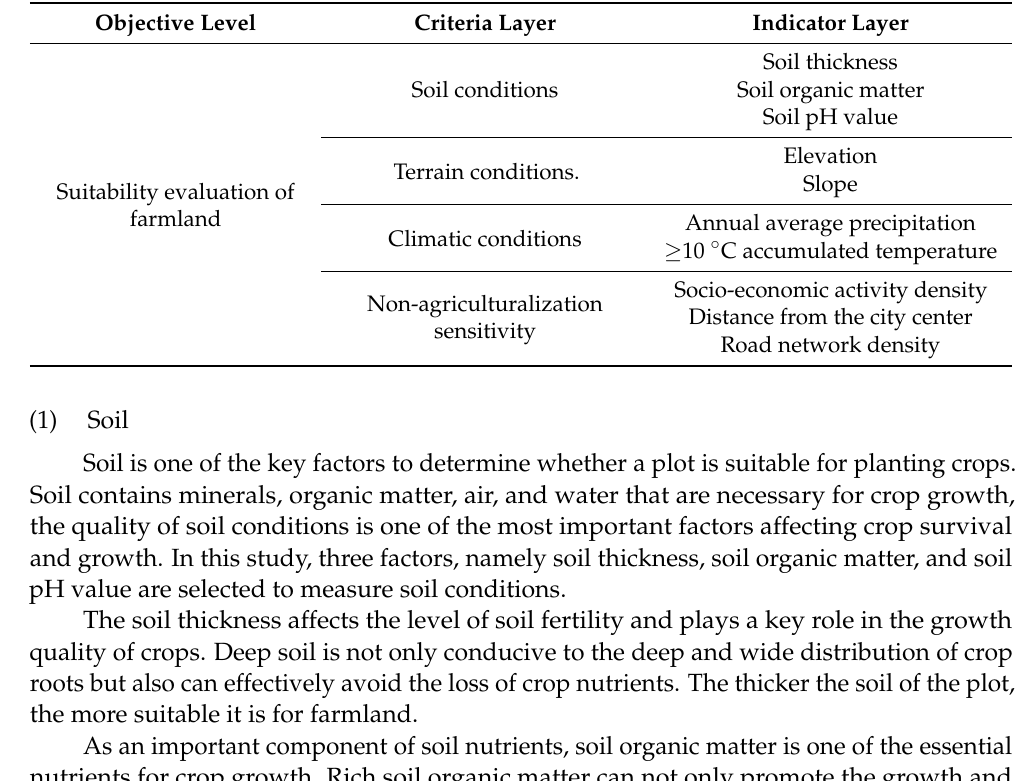
Table 2. Framework of farmland suitability